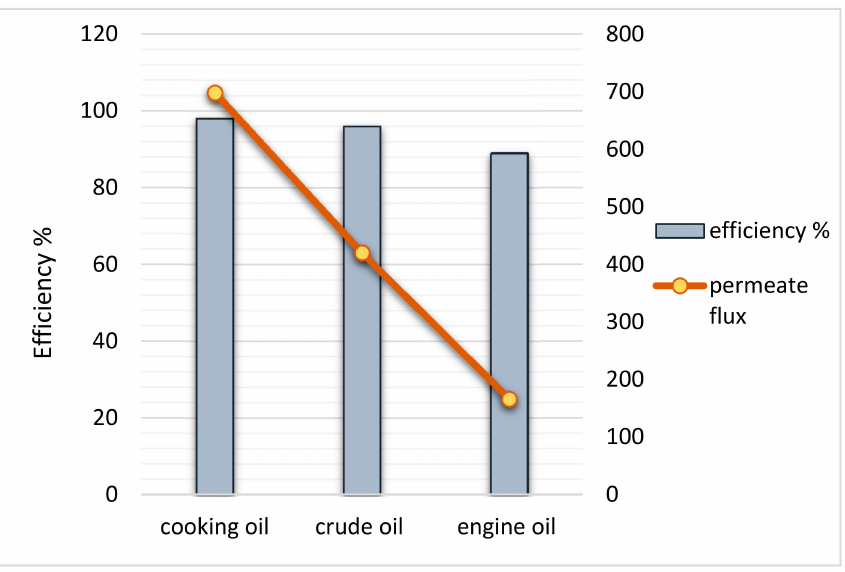
Figure 11. Percentage efficiency and flux (L · m − 2 · h − 1 ) trends for the modified chitosan–gelatin membrane with used cooking oil, light crude oil, and used engine oil with water